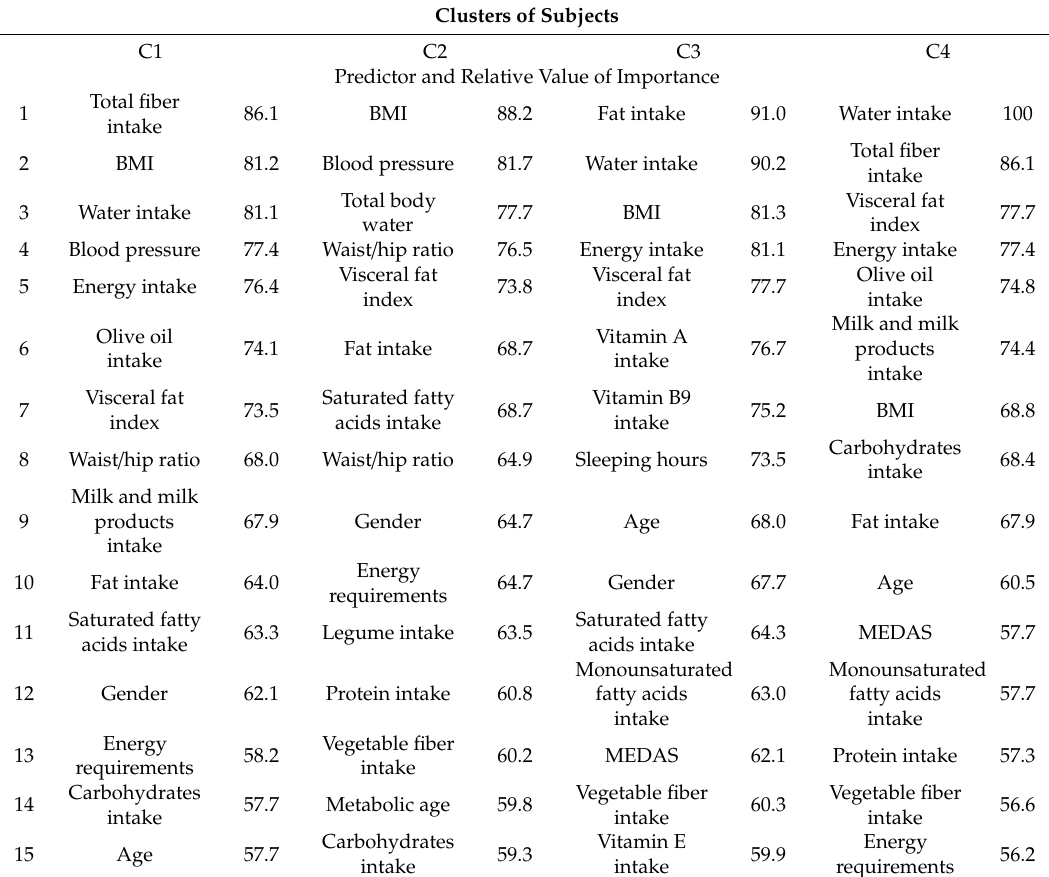
Table 2. The list of demographical, social, nutritional, and medical predictors of four clusters by relative value of